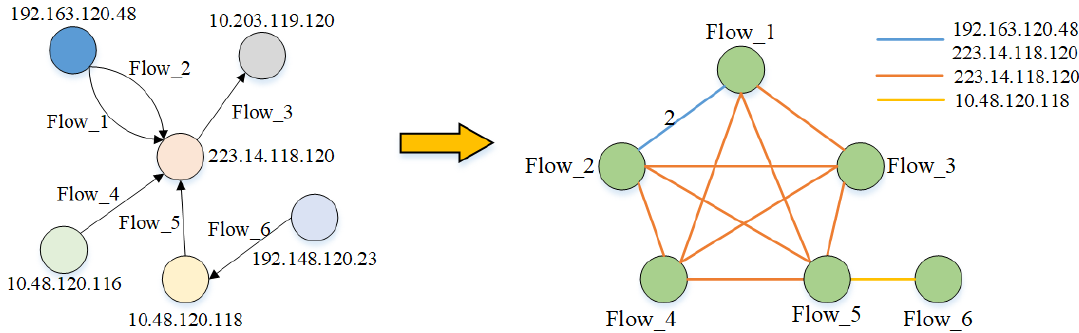
Figure 4. The transformation rule of TIAG.